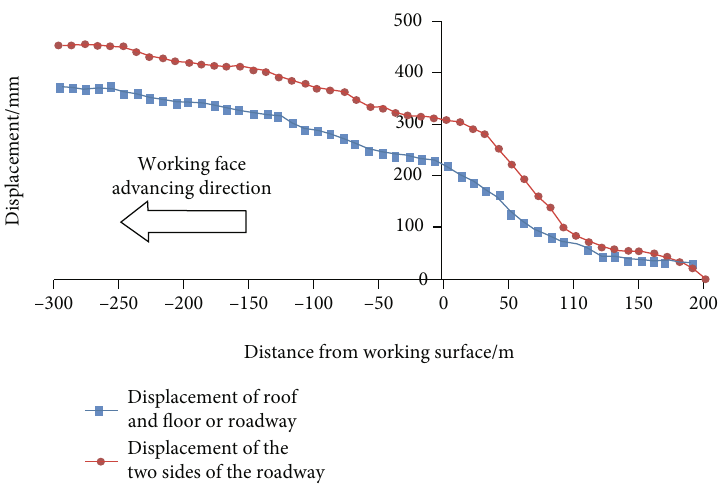
Figure 18: Approaching quantity of roof and fl oor and two sides of entry during the mining period of the No. 201 working face.